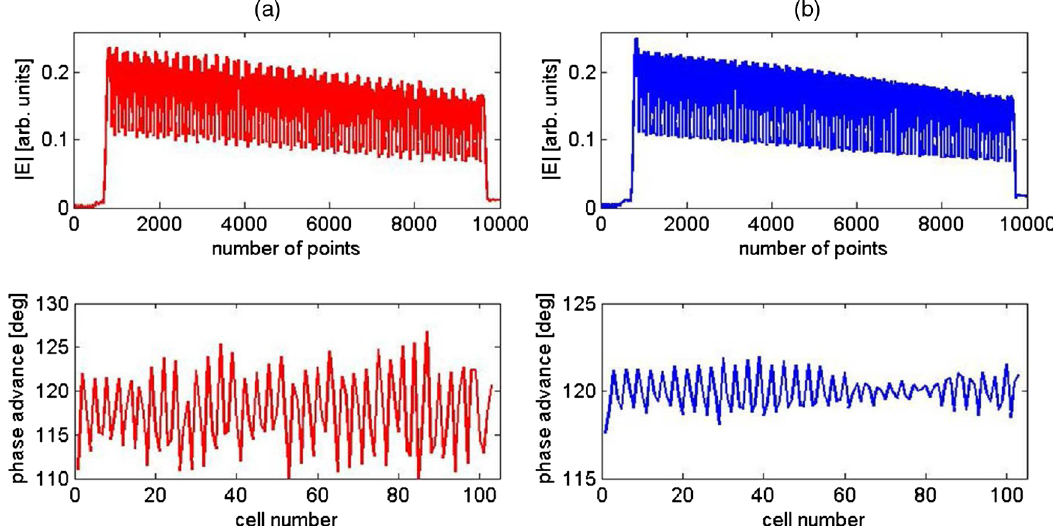
FIG. 12. Magnitude (upper plots) and phase advance per cell (bottom plots) of the sixth accelerating structure before (a) and after (b) tuning.